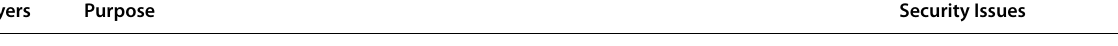
Table 1 IoT layers and security issues